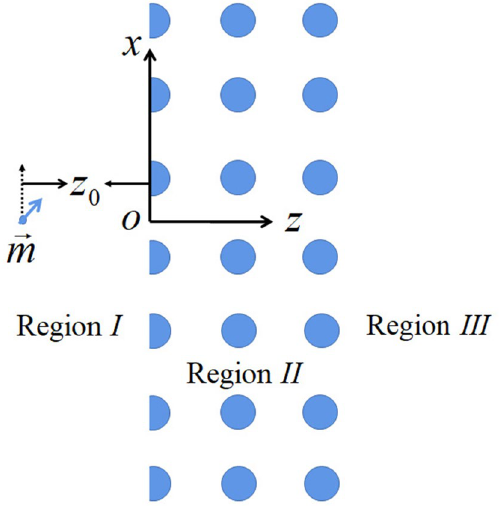
Figure 1. Sketch map of 2D PC slab, a magnetic dipole pillar (cid:31) m is located at x = 0 and z = z 0